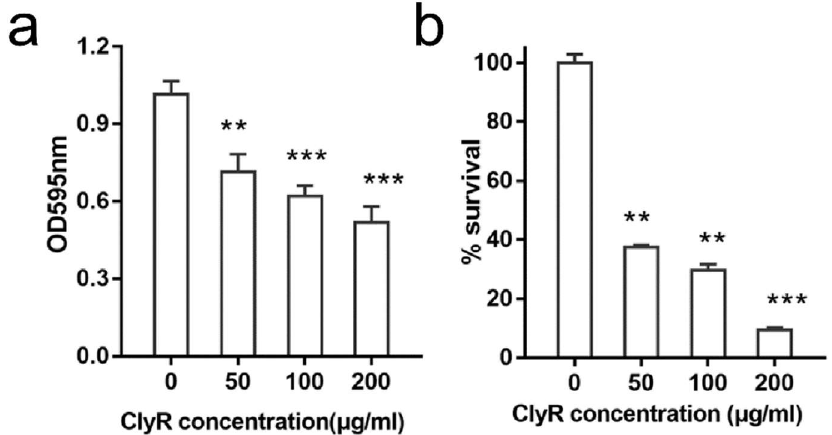
Figure 3. High activity of ClyR against E. faecalis biofilm. ( a ) Crystal violet staining analysis of E.